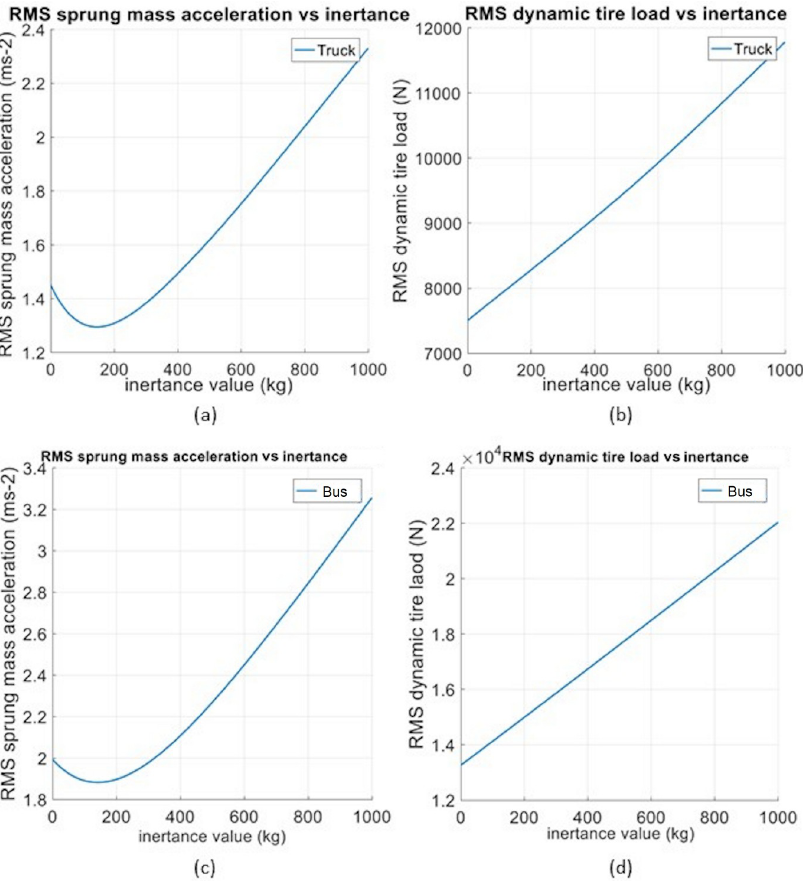
Fig 3. (a) RMS sprung mass acceleration and (b) RMS dynamic tire load against parallel inertance for truck, with (c) RMS sprung mass acceleration and (d) RMS dynamic tire load variation for